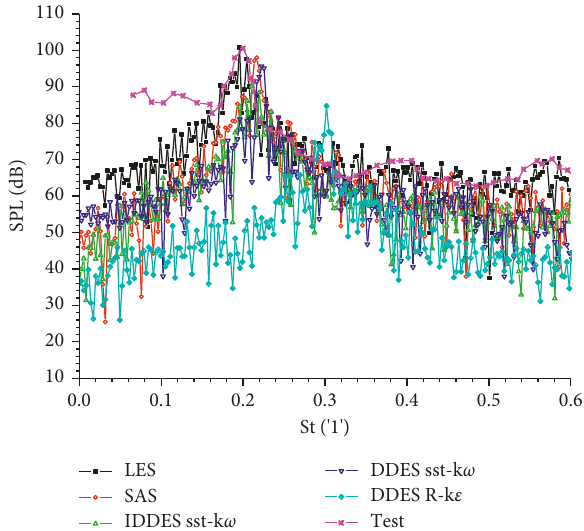
of the four models source Figure 8: Aeroacoustic frequency spectrum curves of the five models at 128d far-right position over the